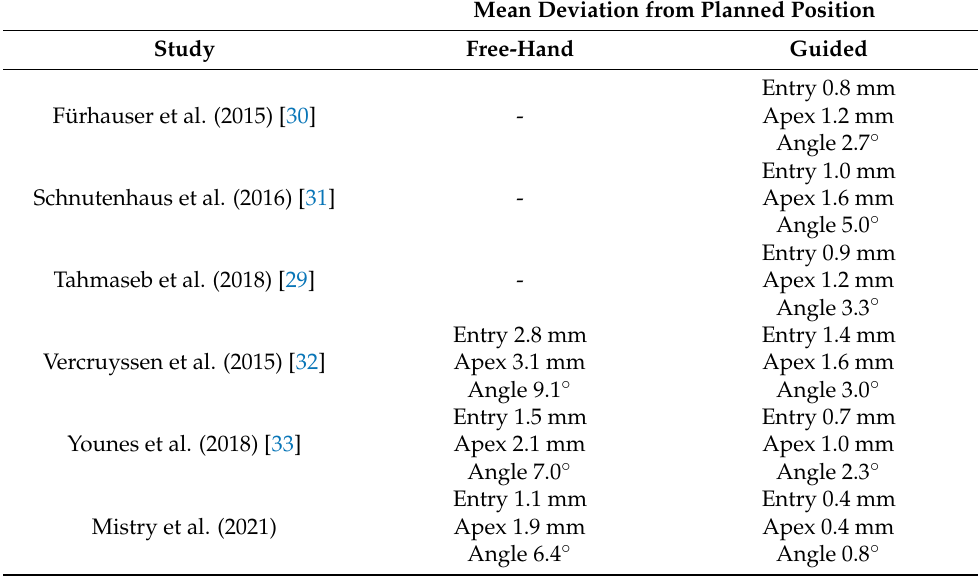
Table 4. Comparing the deviation of planned to placed implant position using free-hand and fully guided